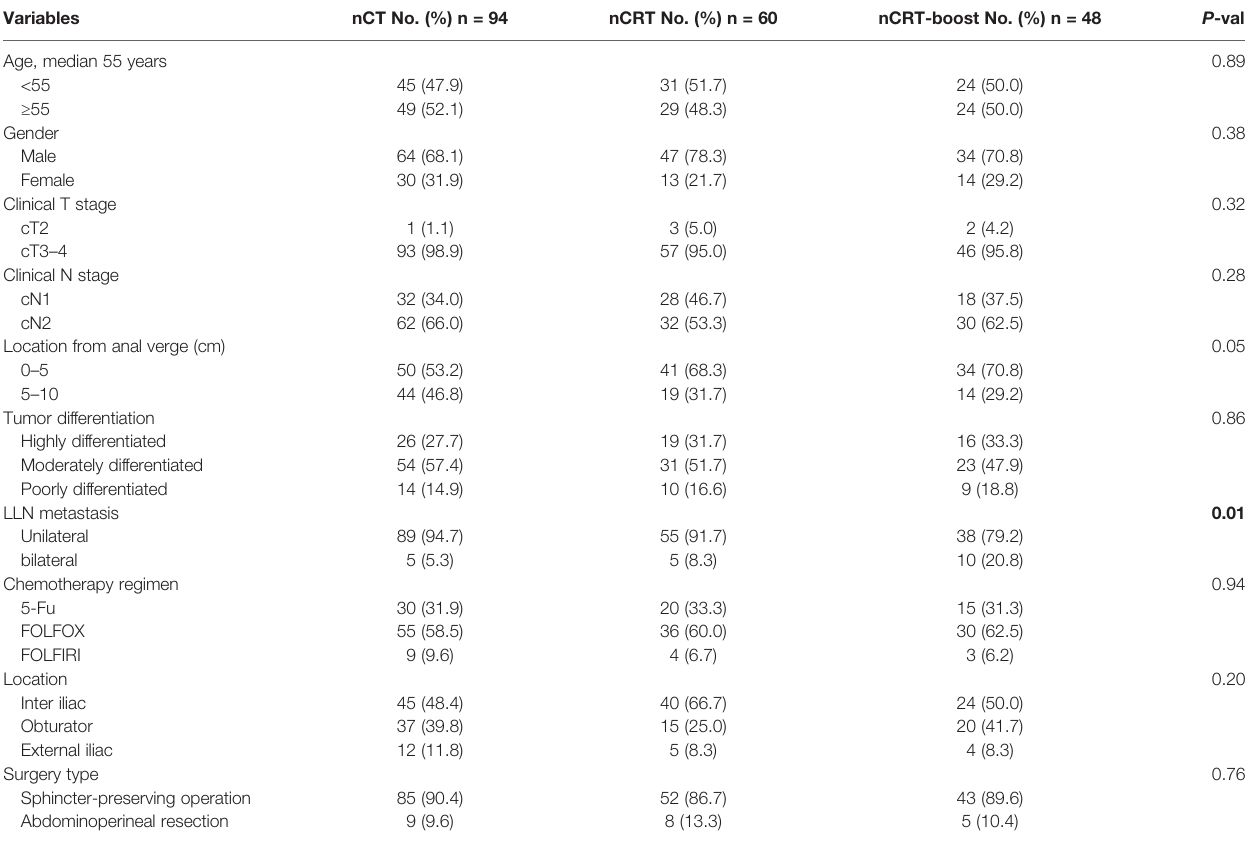
The bold type indicates that the P value is statistically signi fi